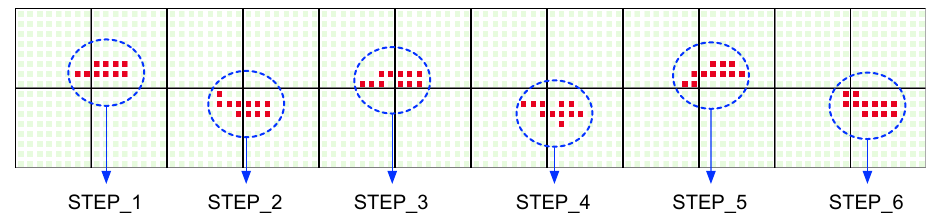
Figure 6. An example of searching footprints.